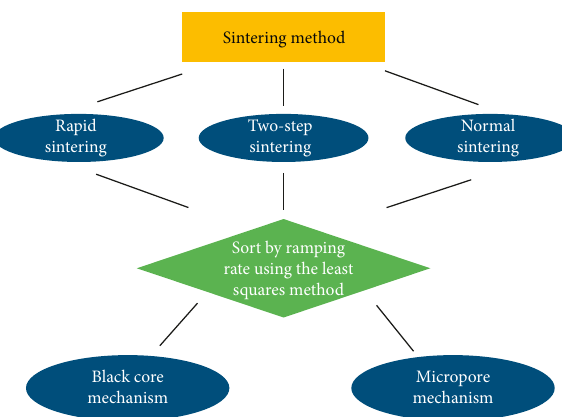
Figure 2: Flow diagram of the experimental routes.